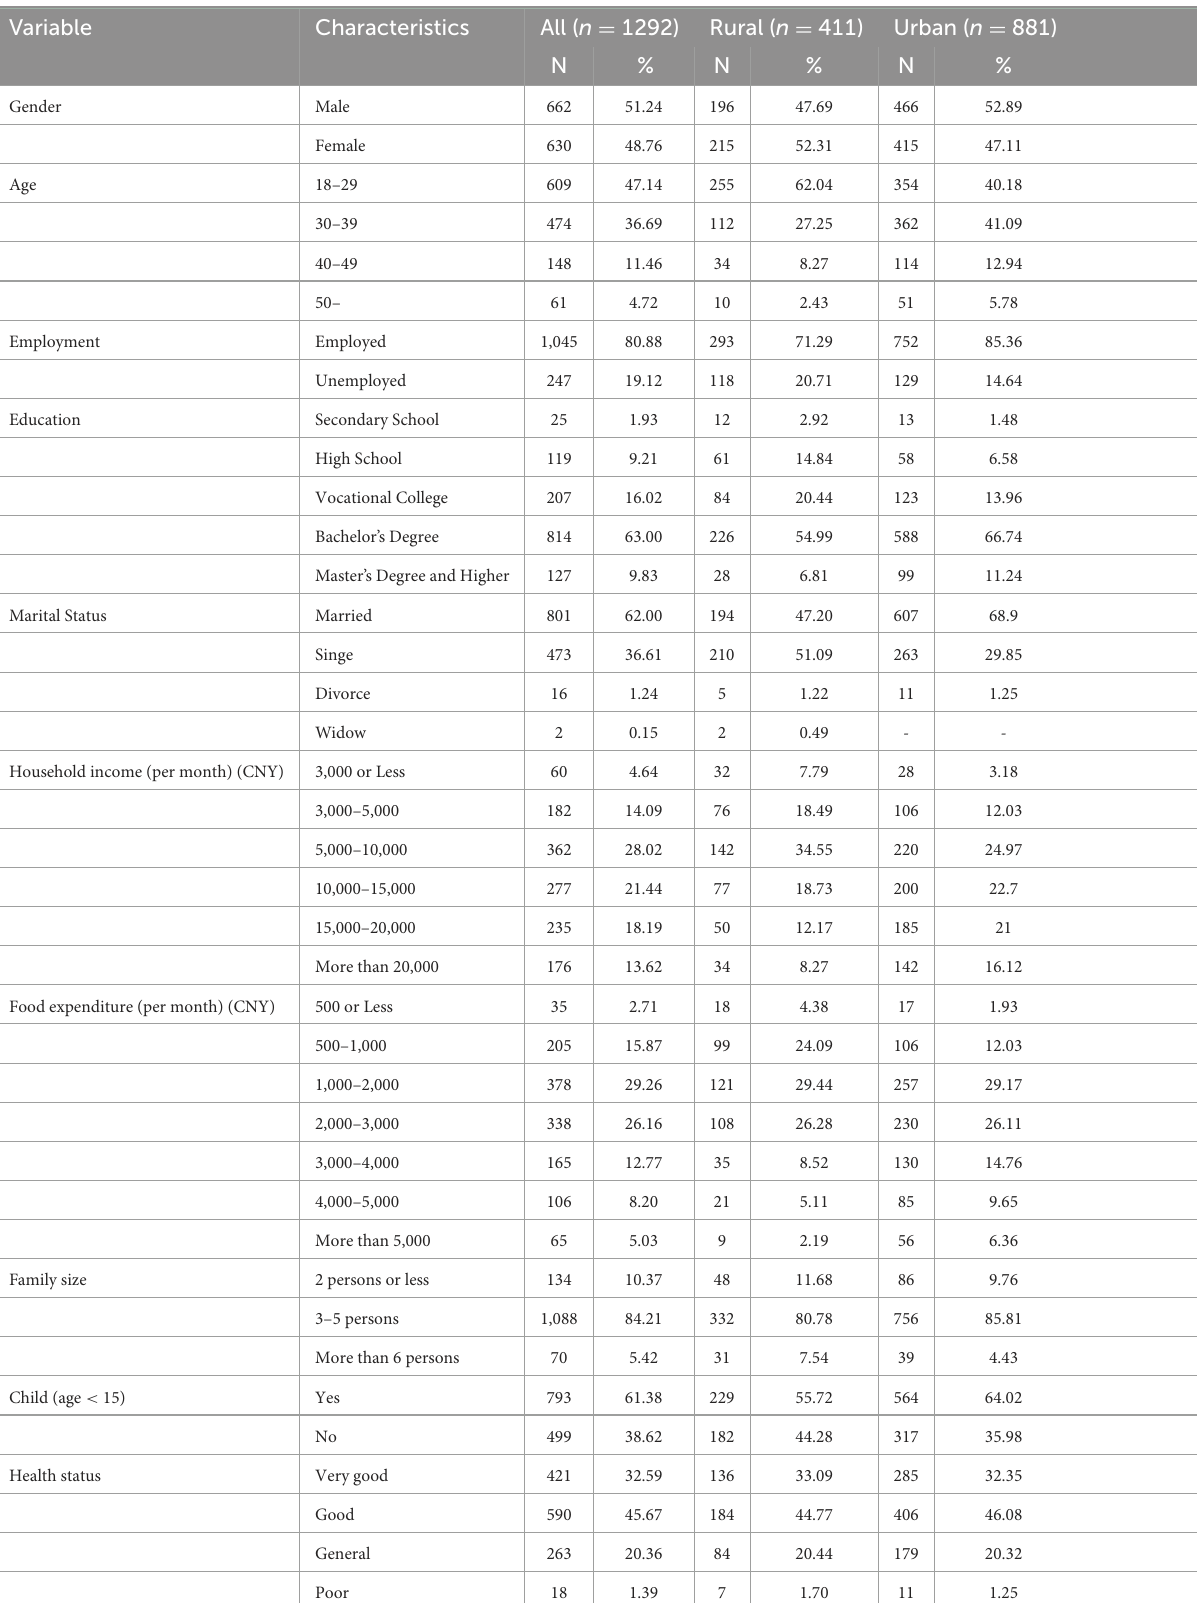
TABLE 3 Socio-demographic characteristics of the sample.